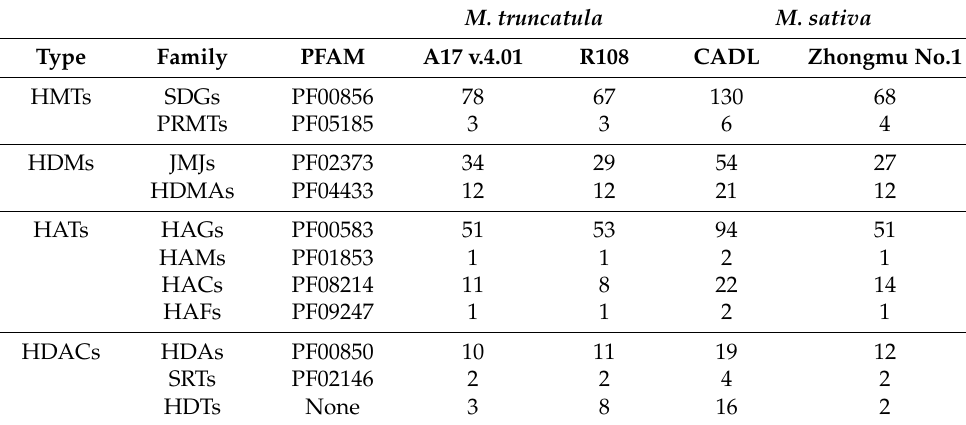
Table 1. Gene numbers of each HMG family in M. truncatula (A17 and R108) and M. sativa (CADL and Zhongmu